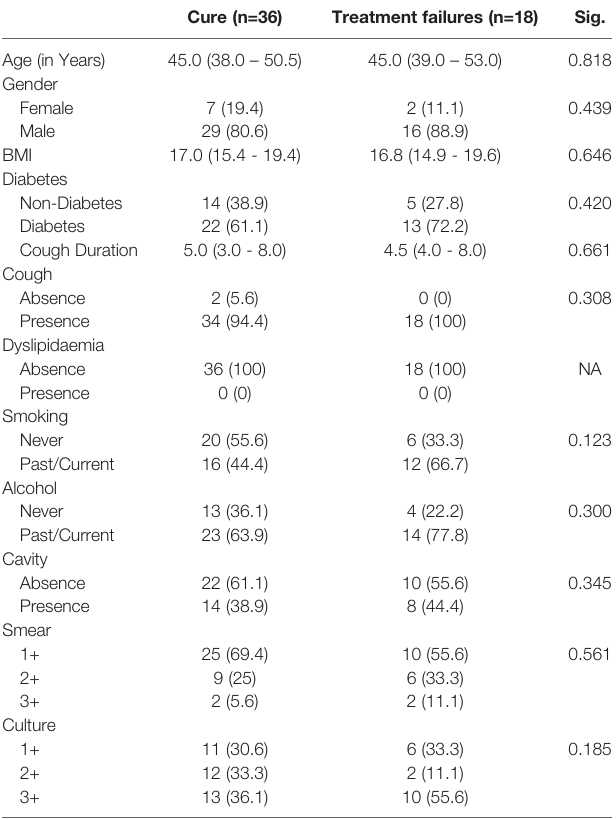
( Figure 3 ). Brie fl y, the data set formed a parent node, which TABLE 1 | Demographic and clinical characteristics of the study population.